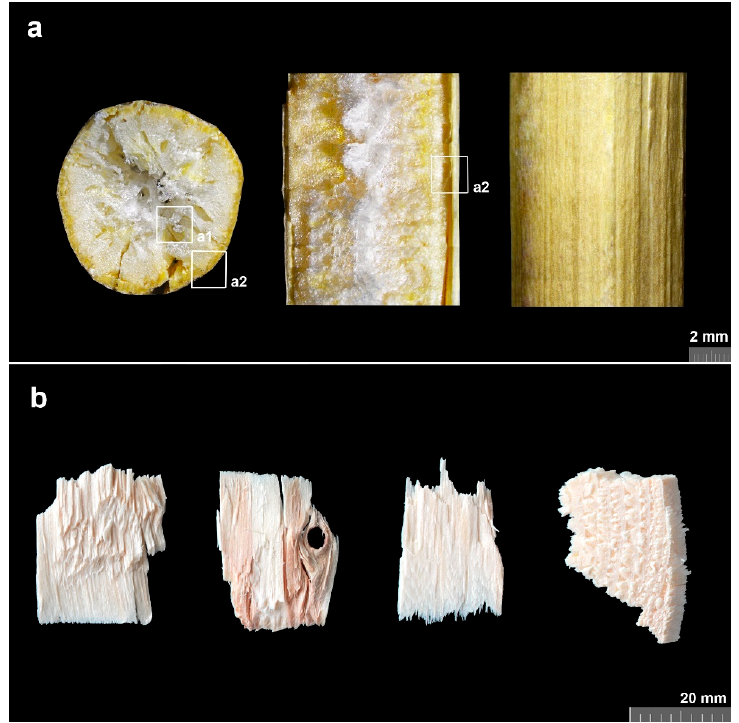
Figure 1. Images of raw materials’ structure from binocular magnifier using scanning